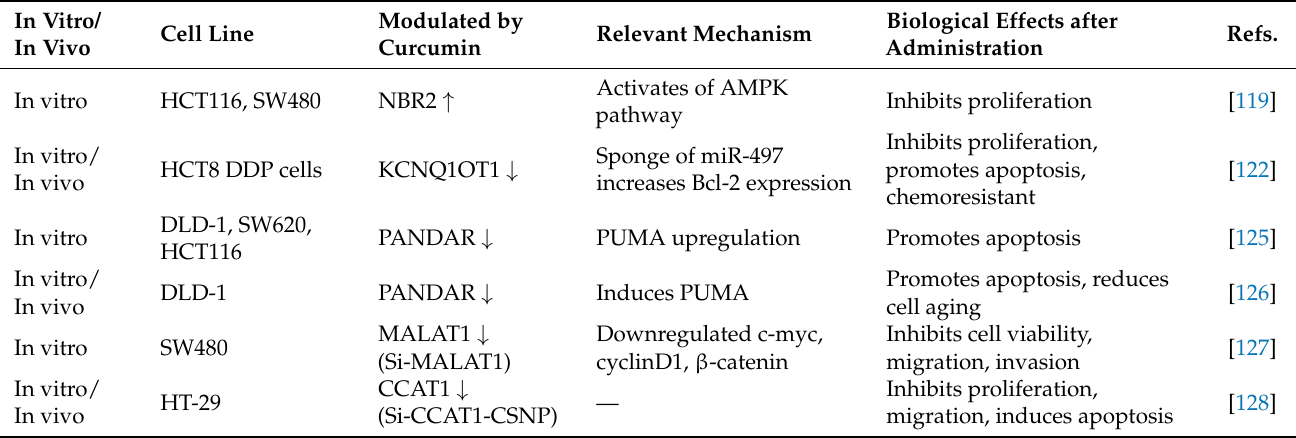
Table 2. Curcumin modulates lncRNAs in colorectal cancer.